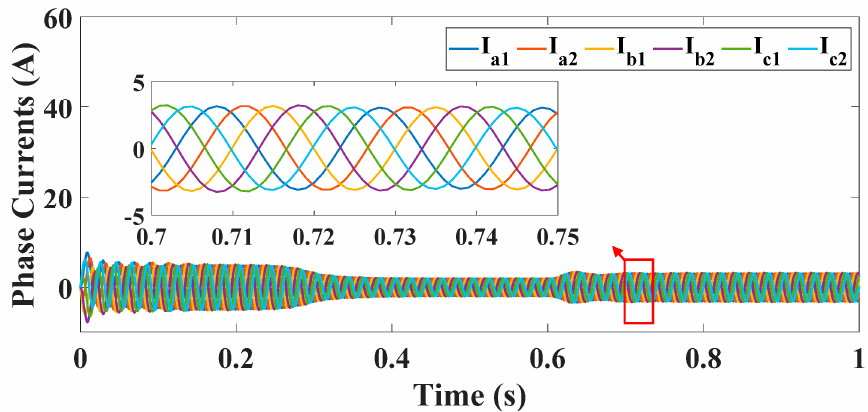
Figure 10. Stator phase currents.